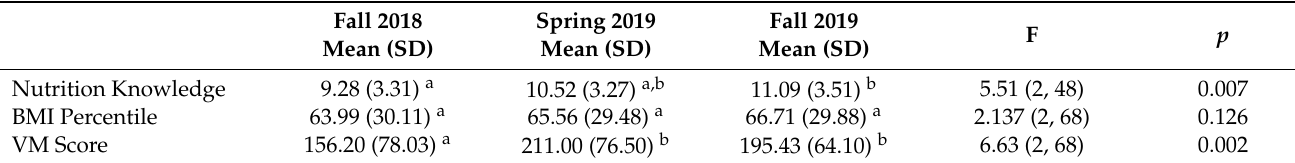
Table 2. Mean nutrition knowledge, BMI percentile-for-age, and VM score for each timepoint.